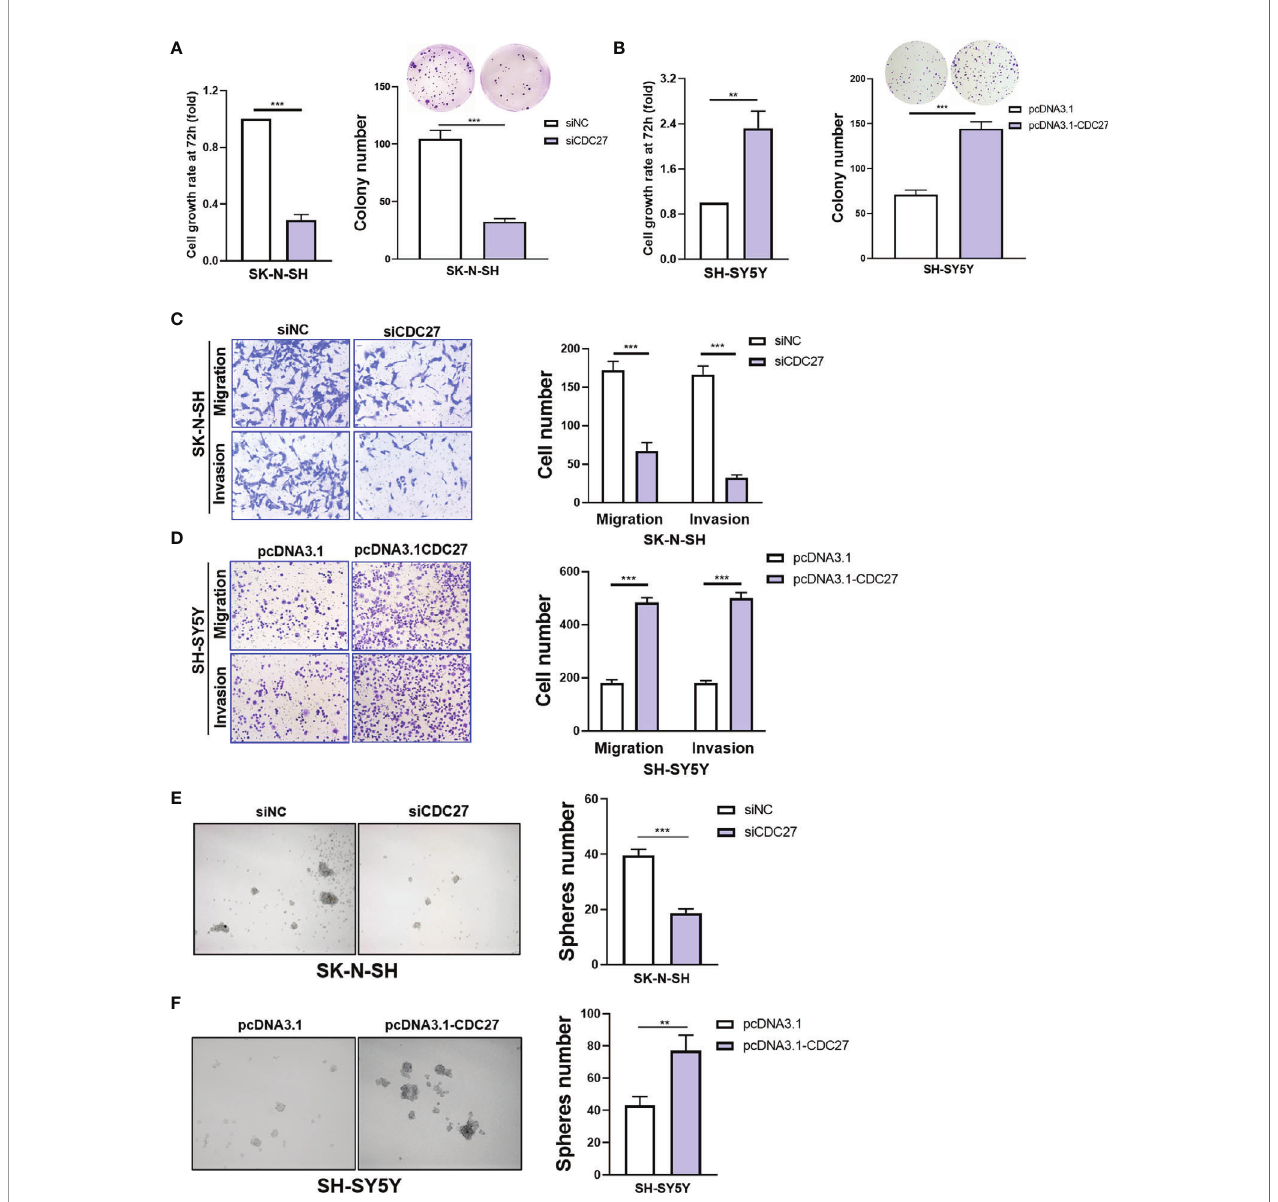
FIGURE 2 | CDC27 promoted cell growth and mobility in NB cells. (A, B) Cell viability and colony-formation ability of the indicated cells with CDC27 downregulation or upregulation were evaluated by MTT and colony formation assays. (C, D) Representative images of Transwell assays show the migration and invasion ability of the indicated cells with CDC27 overexpression or knockdown. Cell numbers were quanti fi ed. (E, F) Representative images show the sphere-formation capability of the indicated cells with CDC27 overexpression or suppression. ***p < 0.001, **p < 0.01 based on Student ’ s t test. These experiments were repeated at least three times. Error bars, mean ±